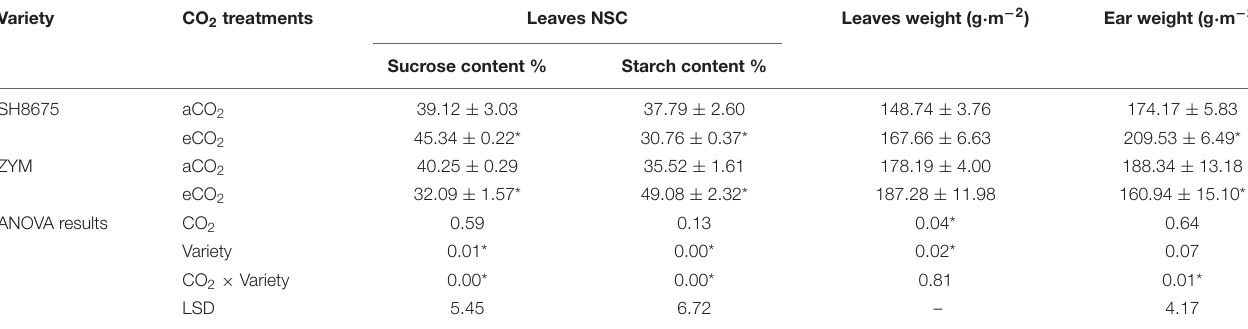
FIGURE 5 | Effects of elevated CO 2 on the (cid:56) PSII and Fv/Fm ratios of two winter wheat varieties (A–C) . Measurements were carried out on intact flag leaves. Data represent the mean of three plants from each plot ± SD (standard error) bars. ANOVA results with * indicate significance at p < 0.05. Vertical bars in (B,C) indicate LSD ( P < 0.05) for (cid:56) PSII and Fv/Fo ratio, respectively. Differences of (cid:56) PSII between varieties in responses to eCO 2 are shown in (C) . TABLE 4 | Effects of elevated CO 2 on agronomic characters of two wheat varieties at anthesis